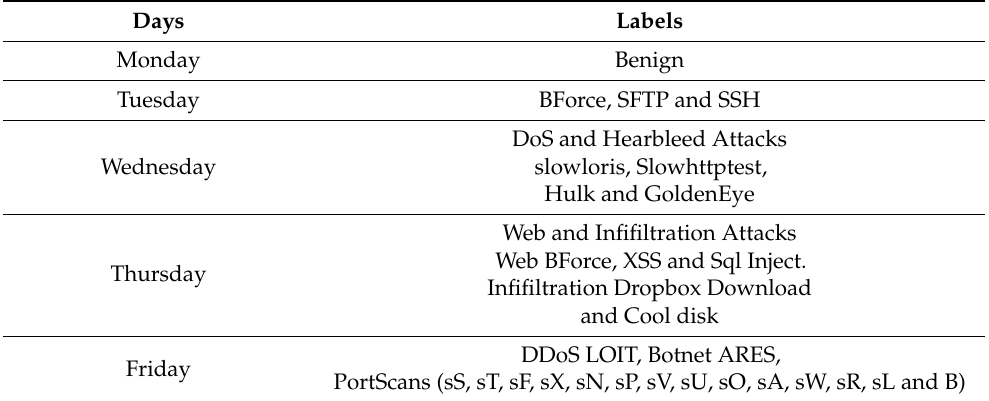
Table 7. Daily label of dataset. [CIC-IDS2017].